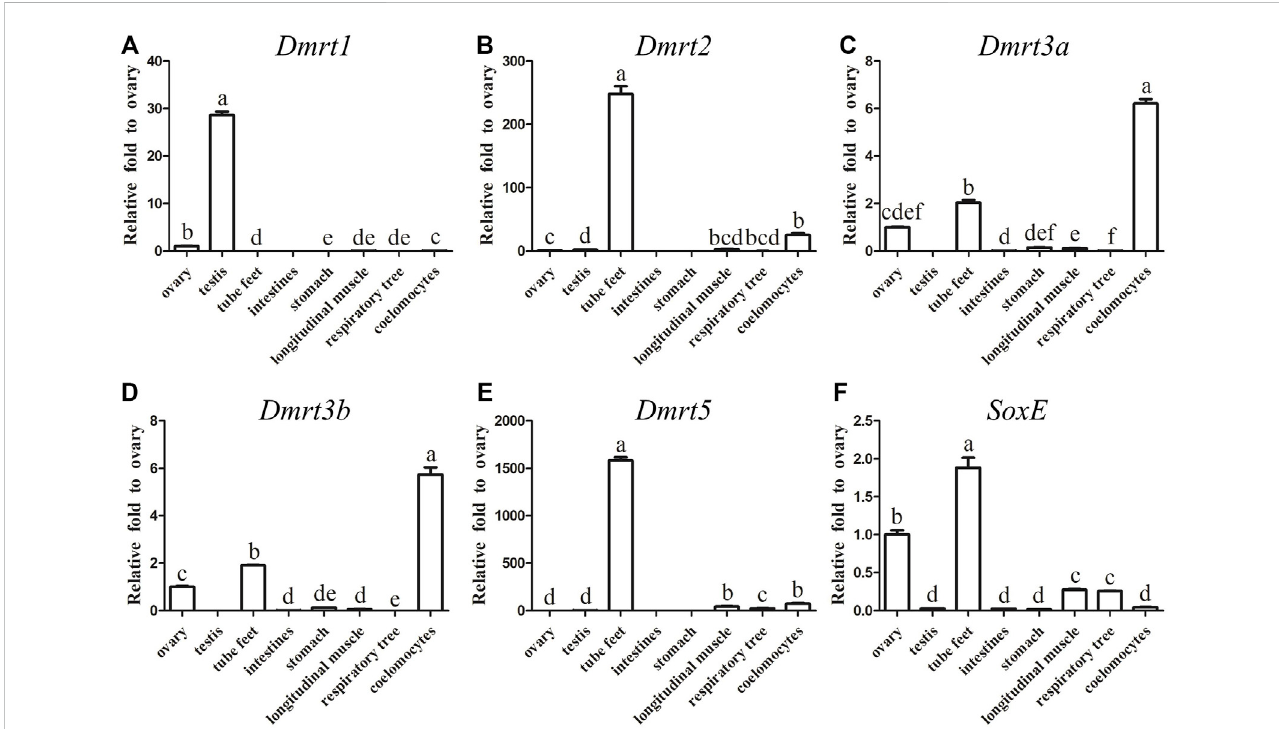
FIGURE 2 RT-qPCR analysis of Dmrts and SoxE Expression in adult tissues. NADH was used as internal control (A) Dmrt1. (B) Dmrt2. (C) Dmrt3a. (D) Dmrt3b. (E) Dmrt5. (F) SoxE. Data were performed from three independent experiments. Each bar represents mean ± SD. Different letters indicate signi fi cant differences between mean values ( p ≤ 0.05), whilst shared letters indicate no signi fi cant difference.